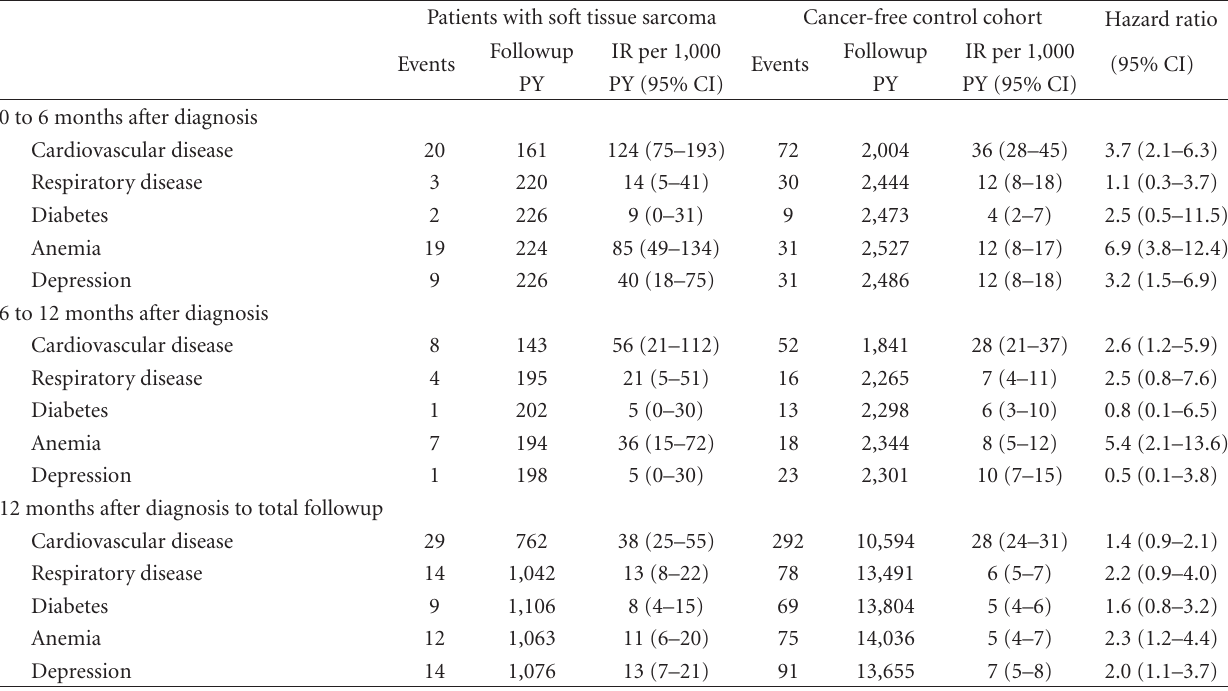
Table 3: Incidence rates of comorbidities ∗ stratified by followup time since diagnosis of soft tissue sarcoma, compared to a noncancer